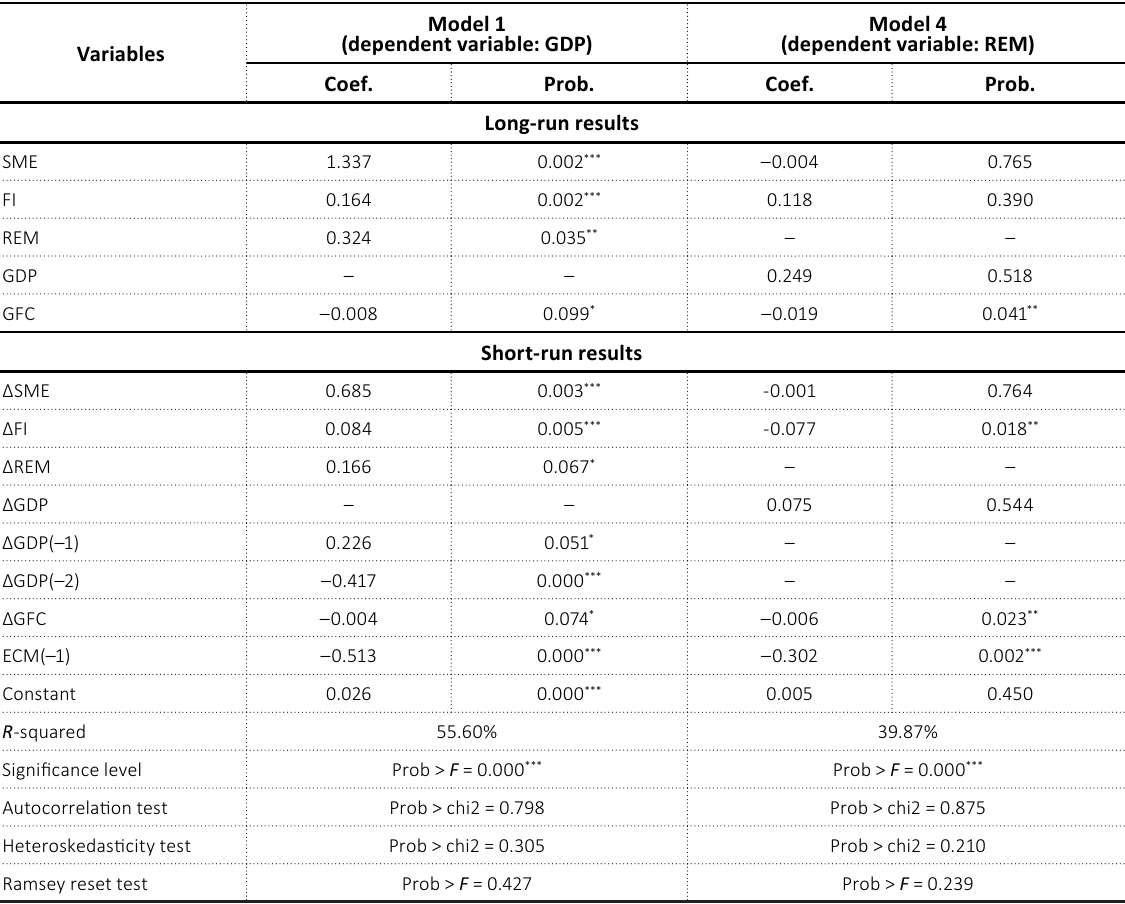
Table 5. Coefficient estimation